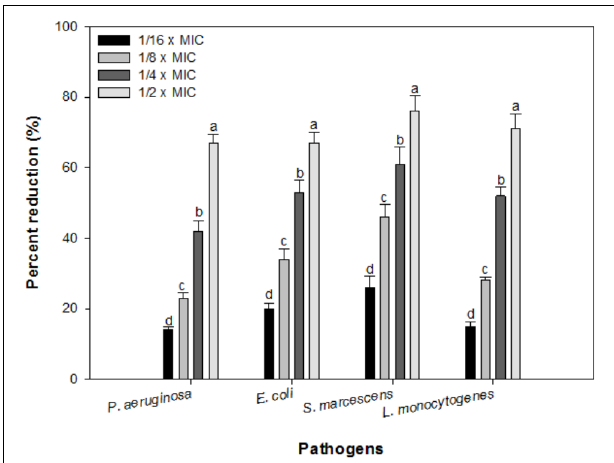
FIGURE 8 | Effect of IONPs on pre-formed biofilms of tested bacteria. Means denoted by the different letter within parameter are significantly different at p > 0.05, using